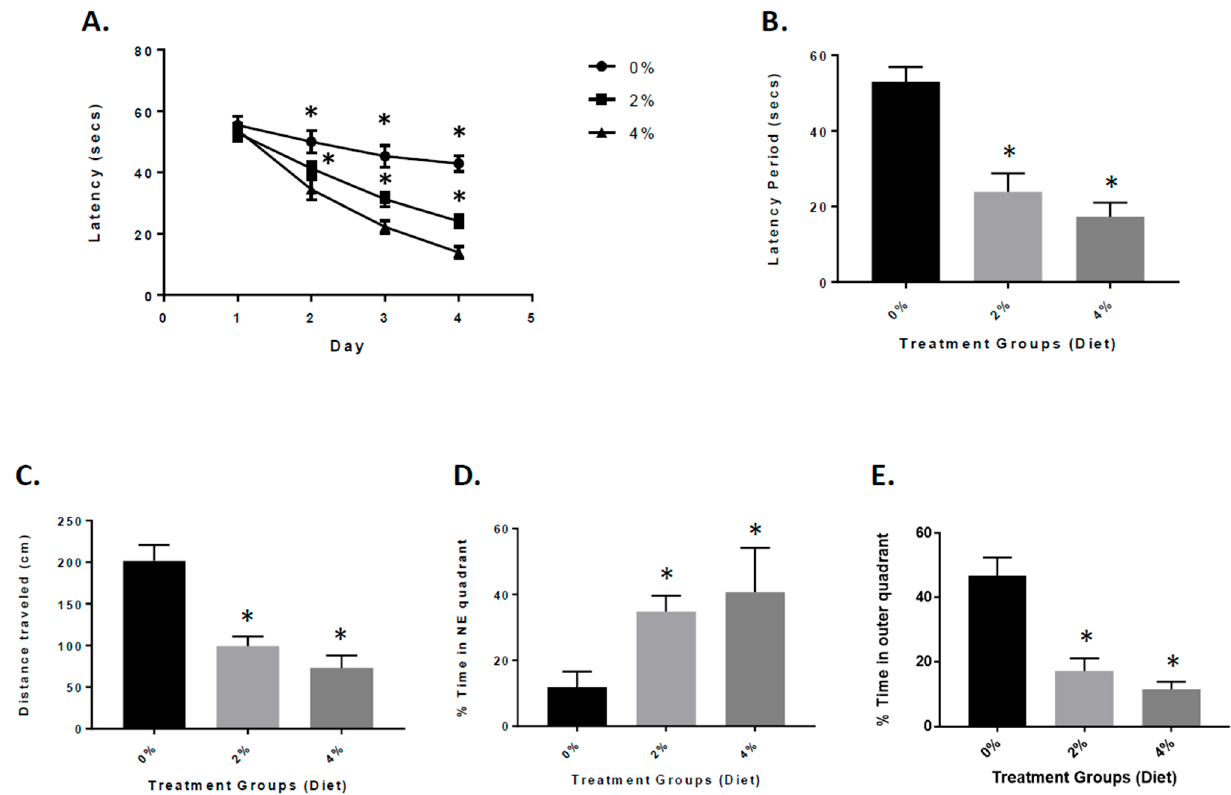
Figure 3. Behavioral analysis of mice treated with GF diets in the Morris water maze. ( A ) APP/PS-1 vehicle, 2% and 4% GF diets were examined for memory acquisition. APP/PS-1 mice were trained in the Morris water maze test on each of 4 consecutive days to learn the location of a submerged, invisible platform in a pool of water. The time that it took the mice to swim to the platform was recorded each day, measured as the latency period (seconds), with shorter latency times indicating better memory acquisition. Latency (secs) is shown as x ± s.e.m. (* Statistically significant, p < 0.05, n = 20 per group). Memory deficits of APP/PS-1 mice were assessed 2 days after completion of the training in the Morris water maze test by measuring the latency period ( B ) and distance traveled ( C ) for animals to swim to the submerged, invisible platform. The shorter latency periods and shorter distances traveled indicate improved memory. Values are expressed as x ± s.e.m., and n = 20 per group. *Statistically significant ( p < 0.001). The percent time each animal swam in the quadrant from which the platform had been removed (Northeast (NE) quadrant (target quadrant), ( D ) and the percent time an animal swam in the annulus of the pool were recorded ( E ). Values are expressed as the mean ± s.e.m., and n = 20 per group. * Statistically significant with p < 0.001.